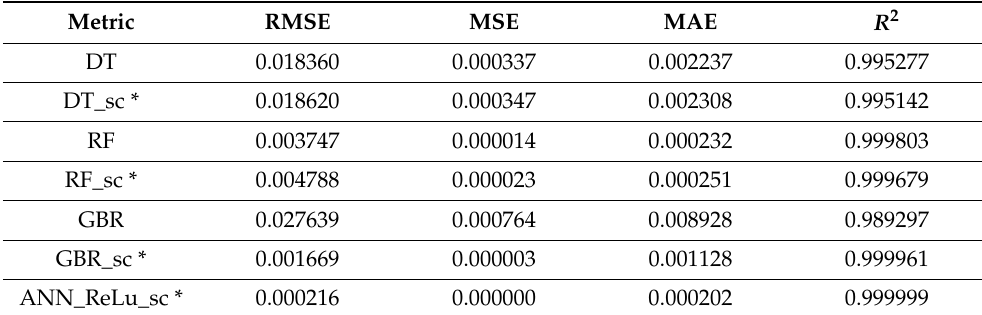
Table 3. Model performance evaluation of two phases dataset for C . Metric